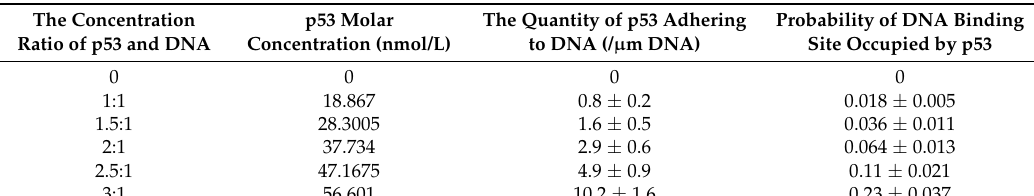
Figure 3. ( a ) AFM images of p53 and 20,000 bp DNA (height images, 1.5 µm × 1.5 µm), when the concentration of p53 and DNA are 4 and 1 ng/µL, respectively; ( b ),( c ) are DNA length and p53 size measure with image J Software, respectively. Table 1. The mean quantities and probability of p53 adhering to 1 µm DNA, corresponding to the concentration ratios of p53 and DNA.